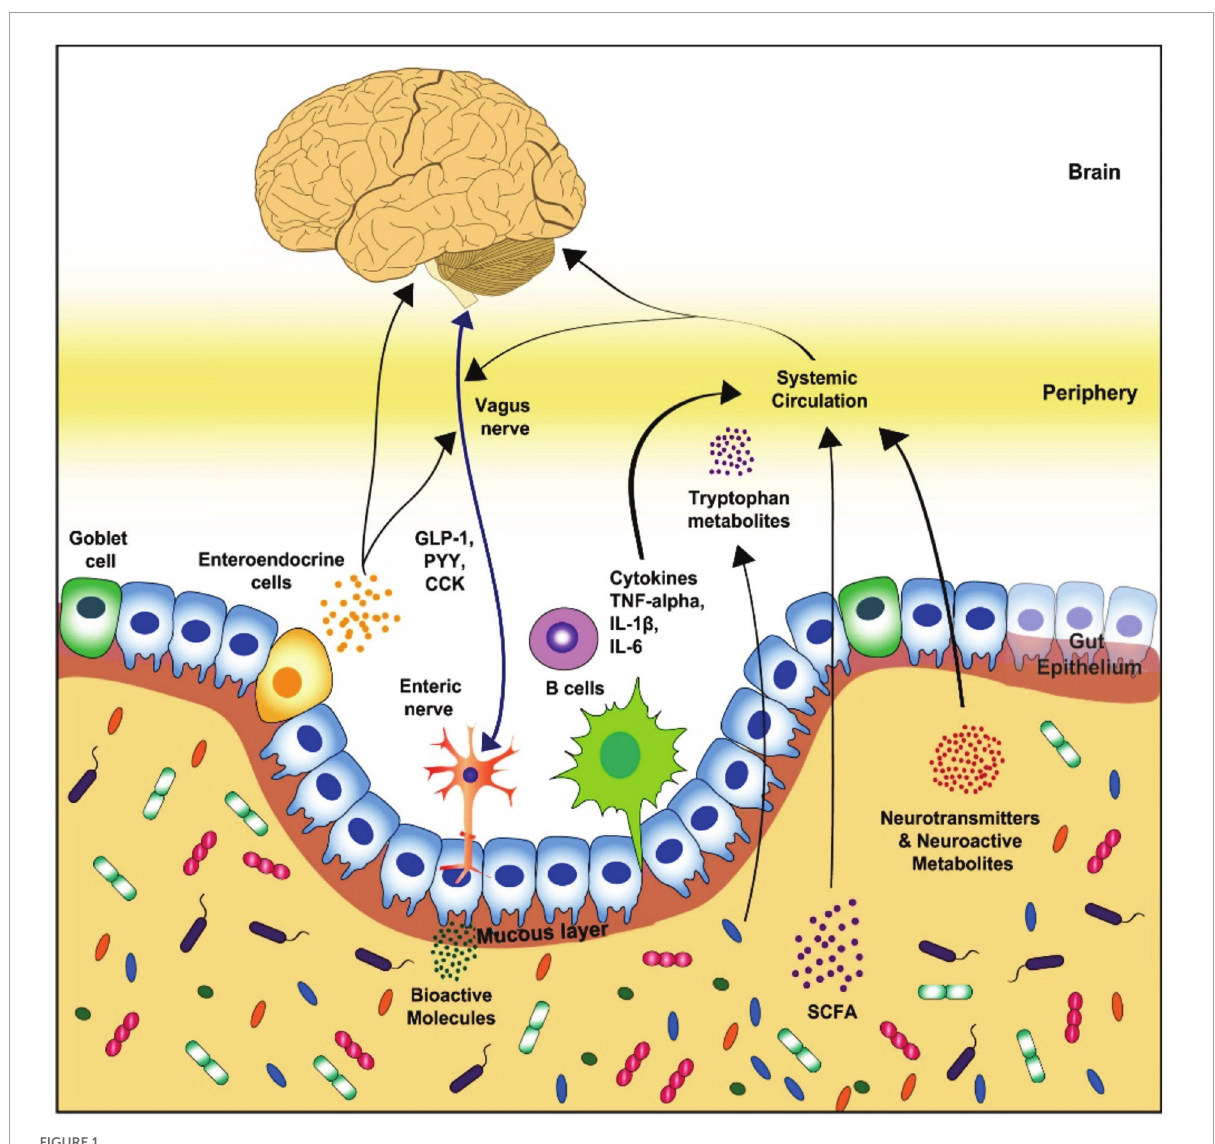
FIGURE1 Schematic representation of the key routes of communication in gut-brain axis (Modified from Cryan et al., 2019). GLP-1, glucagon-like peptide-1; PYY, peptide YY; CCK, cholecystokinin; TNF, tumor necrosis factor; IL, interleukin; SCFA, short-chain fatty